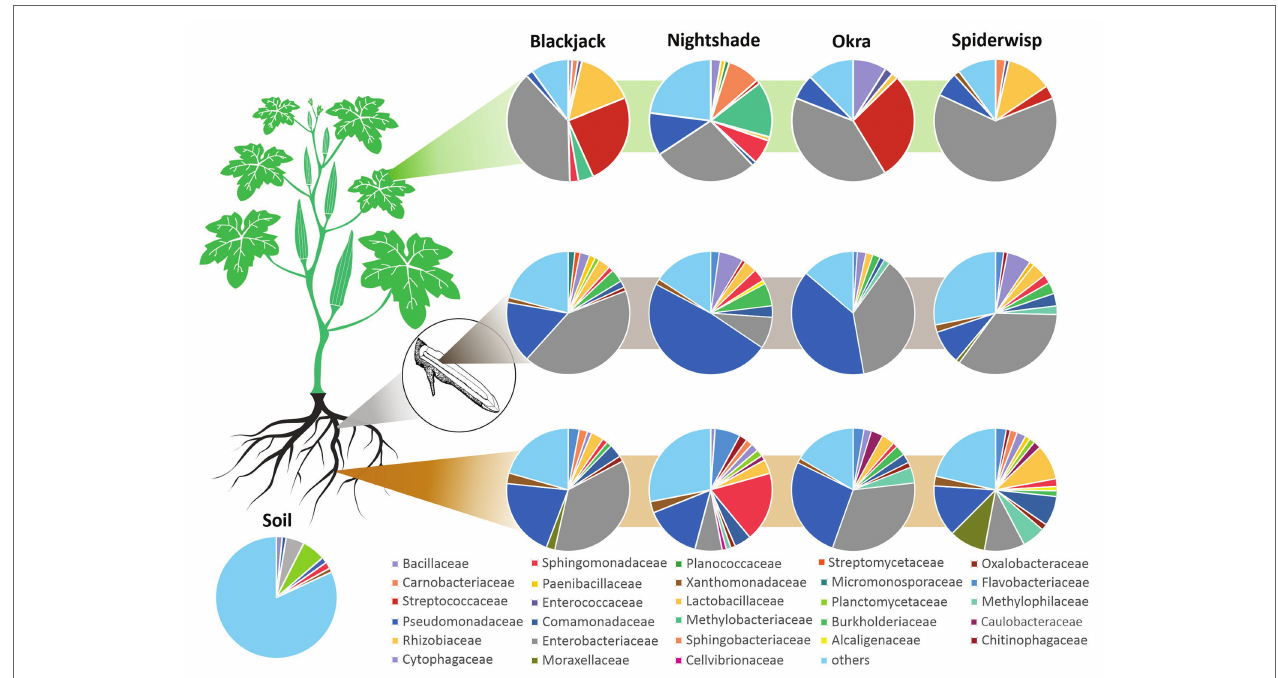
FIGURE 1 | Bacterial core microbiome of leafy greens. The composition of the microbiome of blackjack, nightshade, okra and spiderwisp, and their microhabitats, displayed at the family level: phyllosphere (green stripe), root-endosphere (gray stripe), and rhizosphere (brown stripe). Families with abundances below 1% of total microbiome are captured within